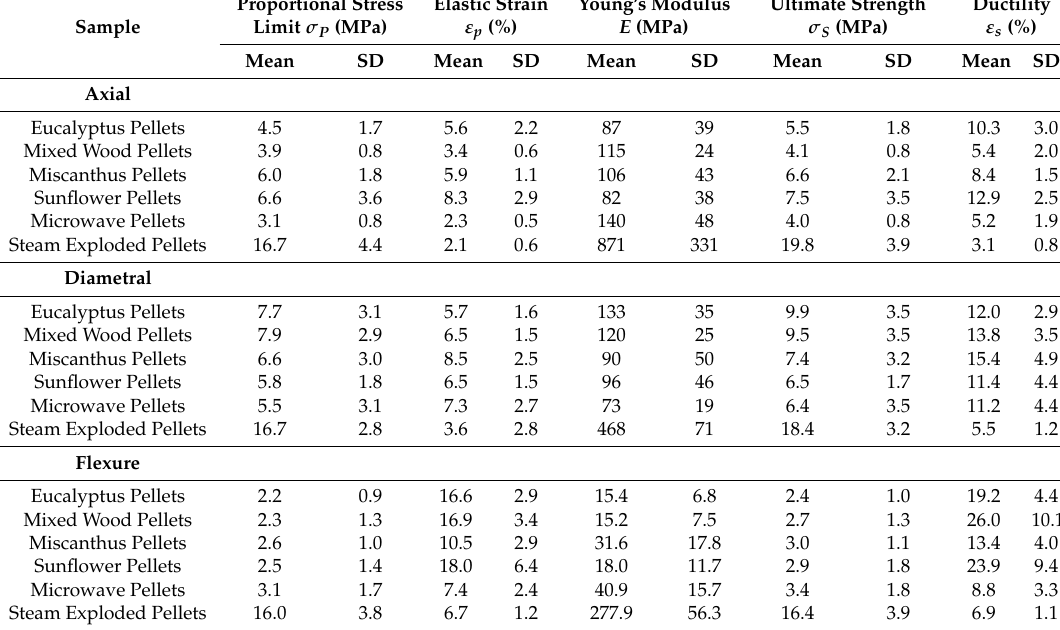
Table 2. Mean and standard deviation (SD) of proportional stress limit σ P , elastic strain ε p , Young’s modulus E , ultimate strength ( σ S ), and ductility ε s , for biomass pellets tested in axial, flexure, and diametral orientations at low strain rates. Standard deviation (SD) is for 10 repeats of each